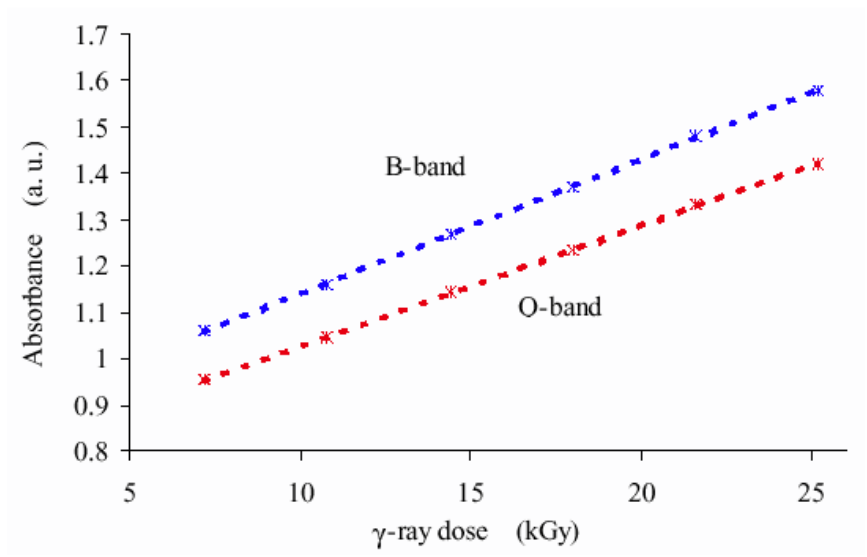
Figure 2. Both B-band and Q-band displayed a linear increase in absorbance in a dose range of 7– 25 kGy.